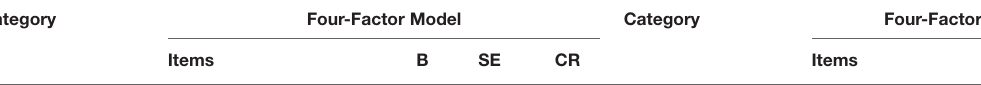
TABLE 3 | Regression weights of four-factor model.